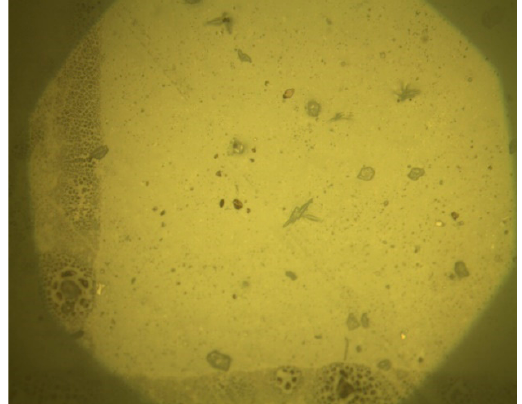
Figure 4. The sample under the metallographic microscope.